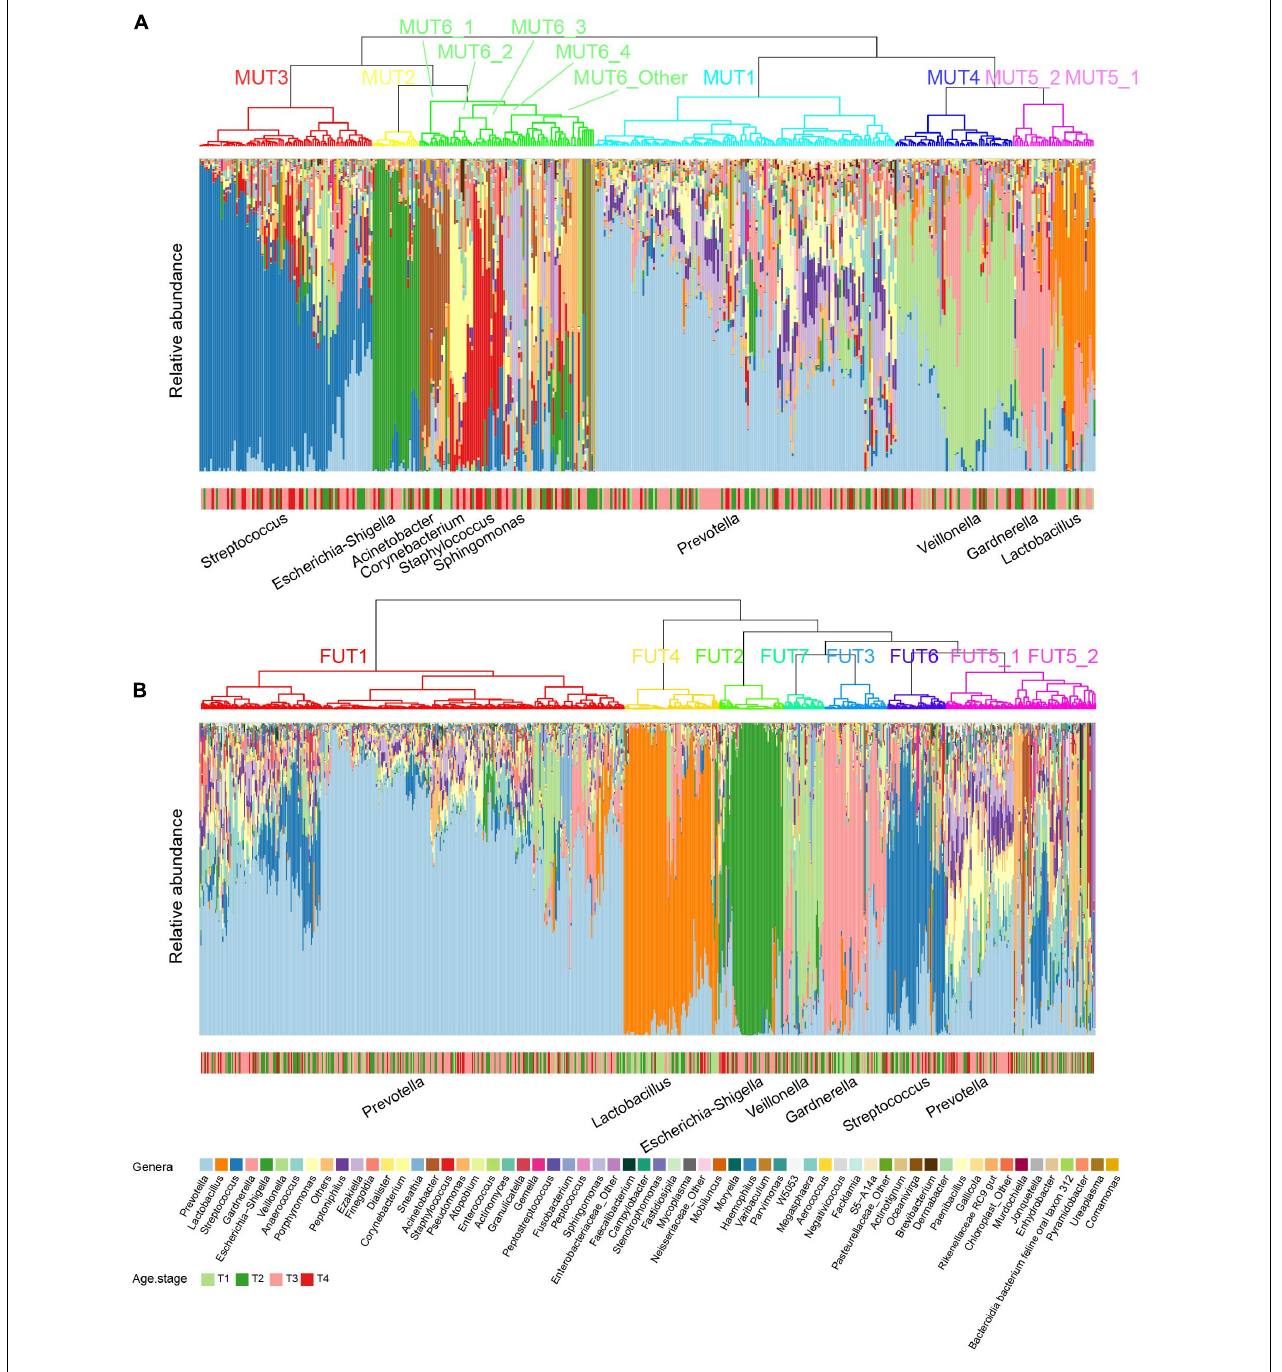
FIGURE 4 | Urotypes of genitourinary microbiome for (A) male and (B) female samples, respectively. Clustering of the samples was performed based on the Bray–Cutis distance using the “ward.D2” clustering algorithm in R. For individual genitourinary microbiota, the relative abundance of 60 most abundant genera (mean relative abundance > 0.1%) is shown, and all others are summarized as